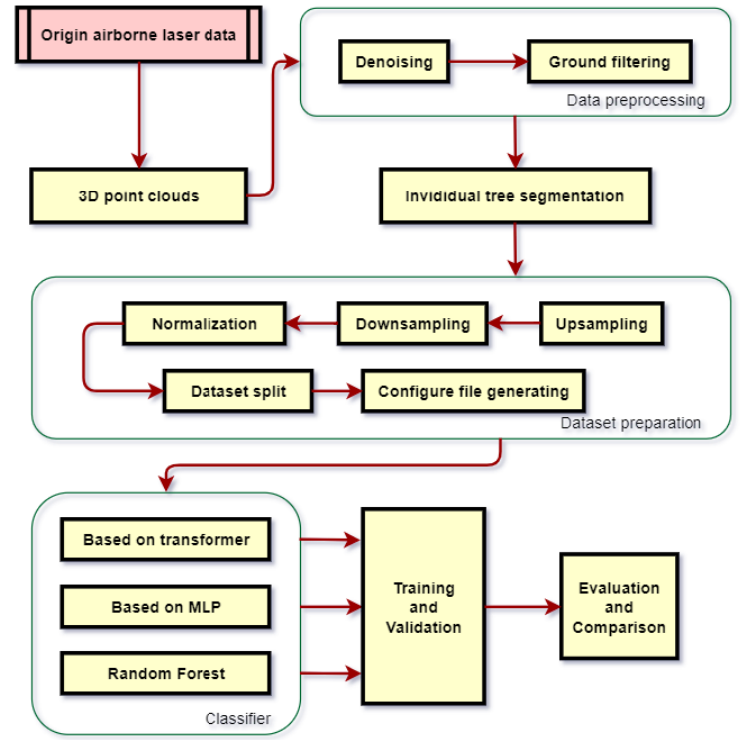
Figure 3. The flowchart of the proposed method.